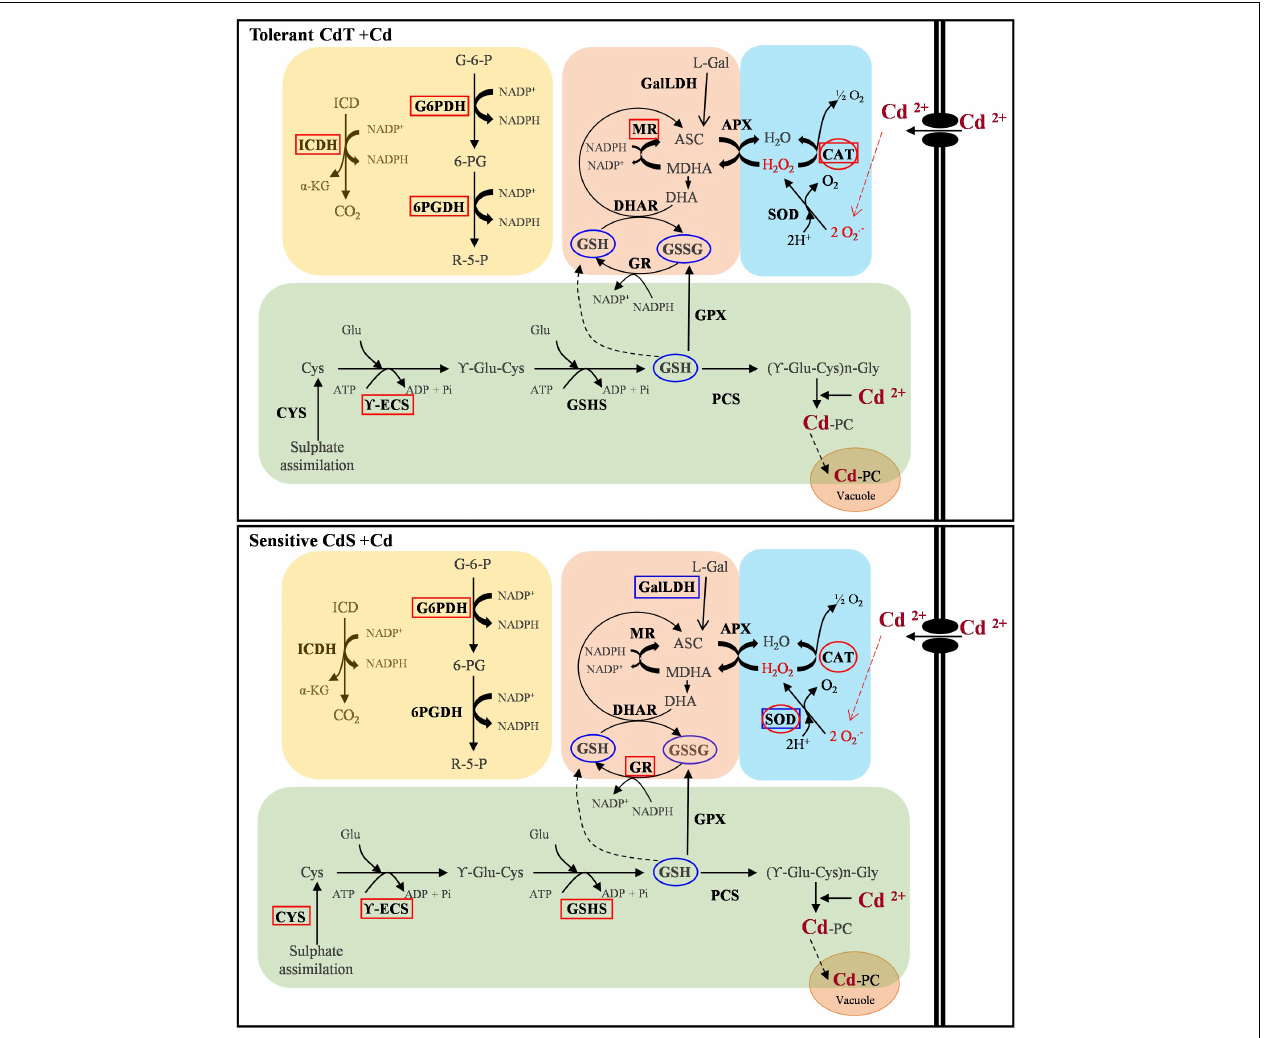
FIGURE 11 | Schematic overview of the contrasting responses observed in M. truncatula cultivars CdT (tolerant) and CdS (sensitive) upon Cd stress relative to gene expression, enzyme activity, and antioxidant content. Analyzed parameter is in bold letter. Rectangles denote a Cd effect on the expression of the gene encoding the enzyme. Ovals indicate a Cd effect on the enzymatic activity or content of non-enzymatic antioxidants. Red and blue colors denote increase and decrease, respectively, as compared with non-Cd treated plants. ASC, ascorbate; CAT, catalase; Cys, cysteine; CYS, cysteine synthase; DHA, dehydroascorbate; DHAR, dehydroascorbate reductase; GalLDH, galactono-1,4-lactone dehydrogenase; Glu, glutamic; G6P, glucose-6-phosphate; G6PDH, glucose-6-phosphate dehydrogenase; GPX, glutathione peroxidase; GR, glutathione reductase; GSSG, oxidized glutathione; GSH, reduced glutathione; GSHS, glutathione synthetase; ICD, isocitrate; ICDH, isocitrate dehydrogenase; L -Gal, L -galactono-lactone; MDHA, monodehydroascorbate; MR, monodehydroascorbate reductase; PCS, phytochelatin synthase; R5P, ribulose-5-phosphate; SOD, superoxide dismutase; 6PGDH, 6-phosphogluconate dehydrogenase; γ -ECS, γ -glutamyl-cysteine synthetase; α -KG, α